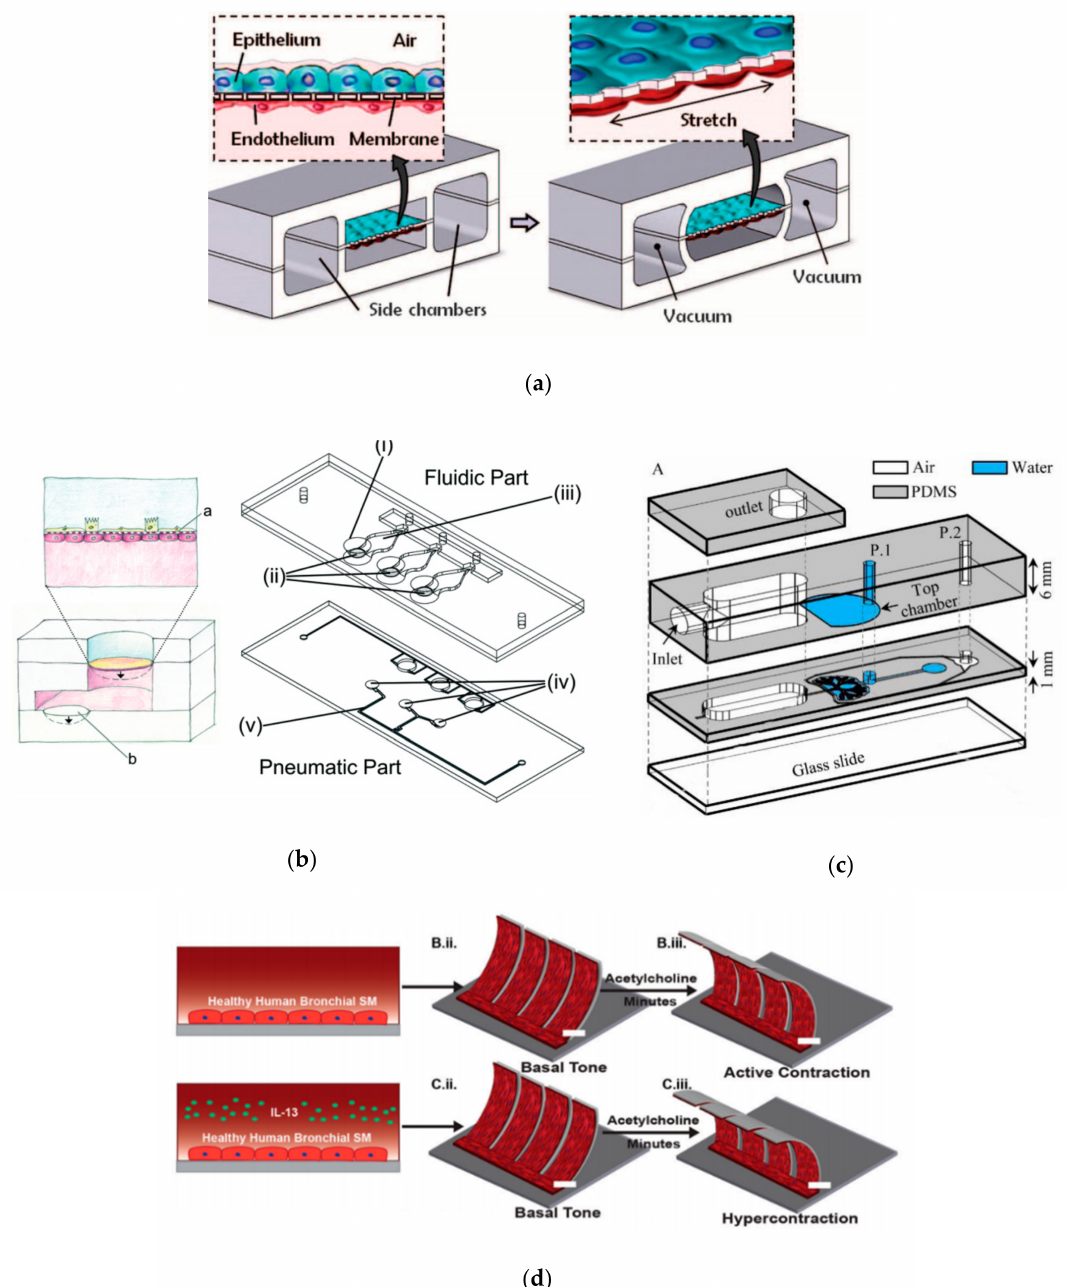
Figure 4. Several representative physiological models of respiratory system based on lung-on-a-chip: ( a ) the lung-on-a-chip that simulates the breathing process through air pressure changes in the side channel produced by Huh et al.; ( b ) the lung-on-a-chip that simulates the breathing process through basement membrane deformation produced by Stucki et al.; ( c ) the lung-on-a-chip that can directly observe the position of particles produced by Fishler et al.; ( d ) the lung-on-a-chip with a special structure that simulates the contraction and relaxation of bronchial smooth muscle produced by Nesmith et al.. Reproduced with permission from